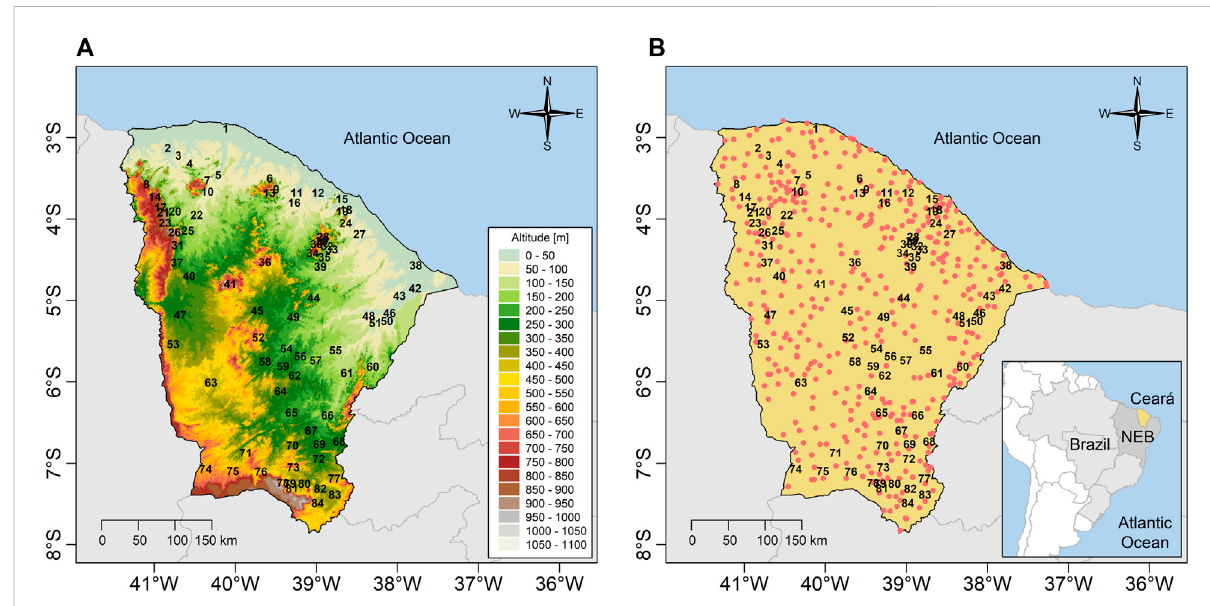
FIGURE 1 (A) AltitudemapofthestateofCearáand (B) raingauge locations andsurroundingstationsinthestudy area.The numbersofthetargetstations are also shown on both maps and the red points are related to the surrounding